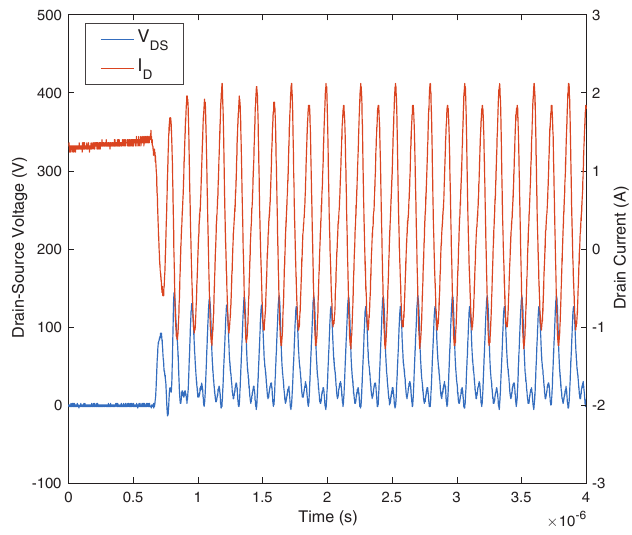
Figure 5. The type II oscillation waveforms of I D and V DS